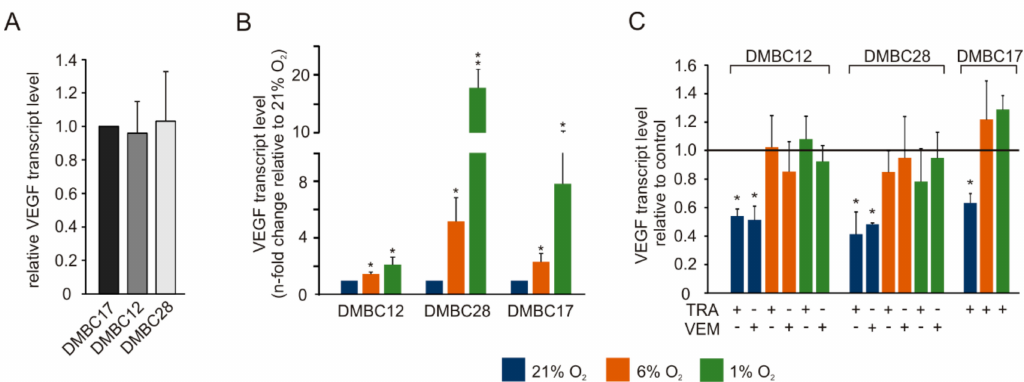
Figure 7. E ff ects of trametinib (TRA) and vemurafenib (VEM) on VEGF transcript level assessed at di ff erent oxygen concentrations. VEGF transcript levels were determined by qRT-PCR and normalized to the expression of a reference gene RPS17. ( A ) Transcript levels of VEGF were determined in cell cultures grown in hyperoxia by qRT-PCR and their expression is compared between cell lines with transcript levels in DMBC17 cells set as one. ( B ) Transcript level of VEGF in 6% O 2 and 1% O 2 is presented relative to its level in 21% O 2 . ( C ) Changes in VEGF transcript level after drug treatment is presented relative to its expression in control. Bars represent mean values of 3-4 independent experiments ± SD. Di ff erences are considered significant at * p < 0.05, ** p <